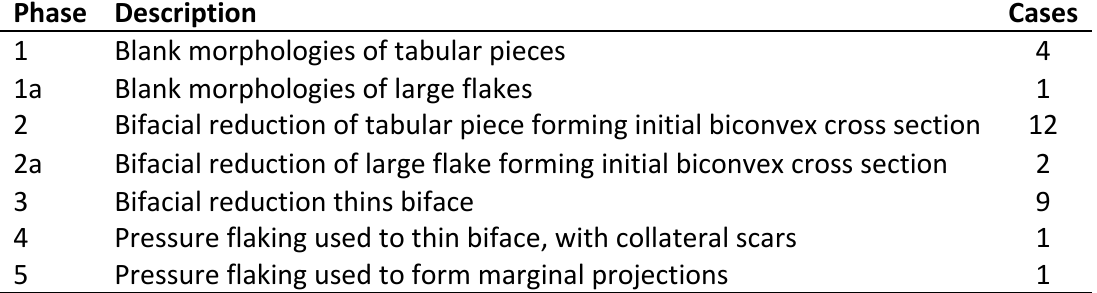
Table 14. Biface production phases from the Mandanari